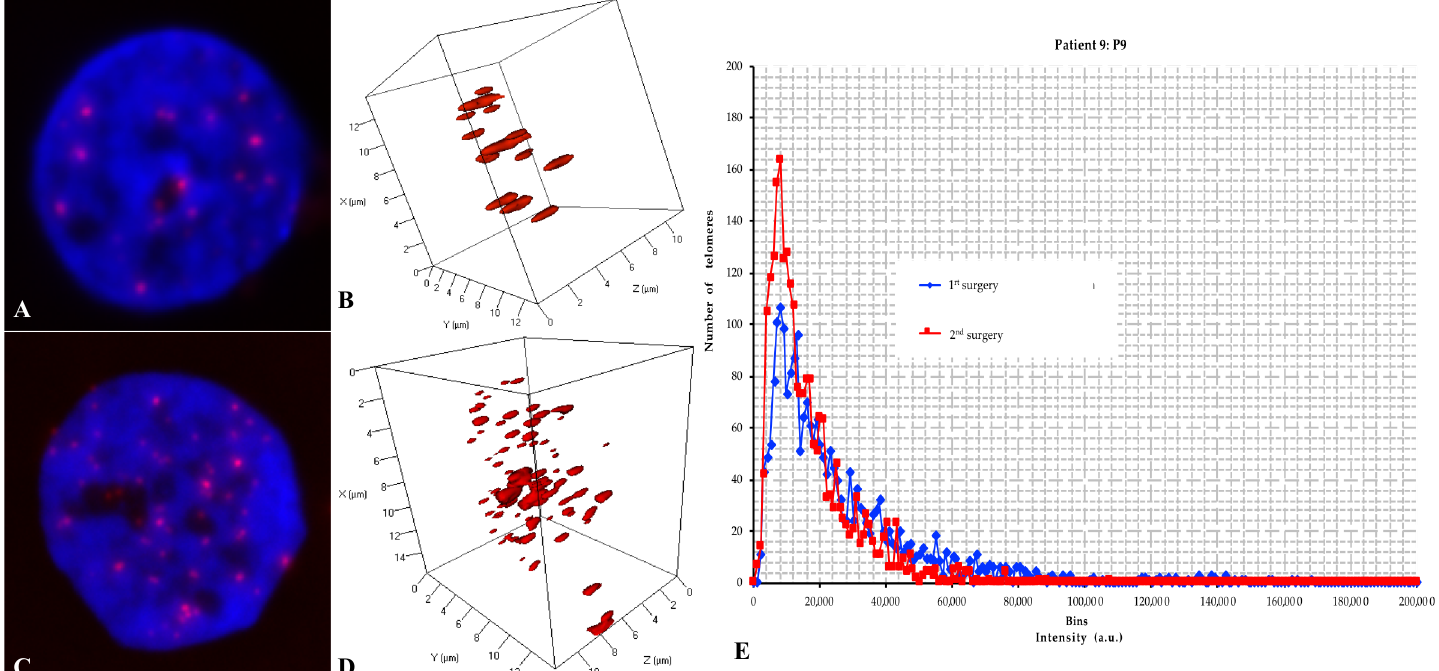
Figure 2. In an example of a group-1 patient (from patient 9: P9), a representative nucleus (1 × 1000 magnification) with 2D QFISH at first surgery ( A ) and at second surgery ( C ); representative nucleus with 3D QFISH at first surgery ( B ) and at second surgery ( D ); and a representative combined 3D telomere profiles displaying the distribution of the total number of signals (total number of telomeres) versus their intensities (telomere length) at both surgeries, respectively ( E ) for patients with short-term recurrence (P9: TTP = 232 days and OS = 1103